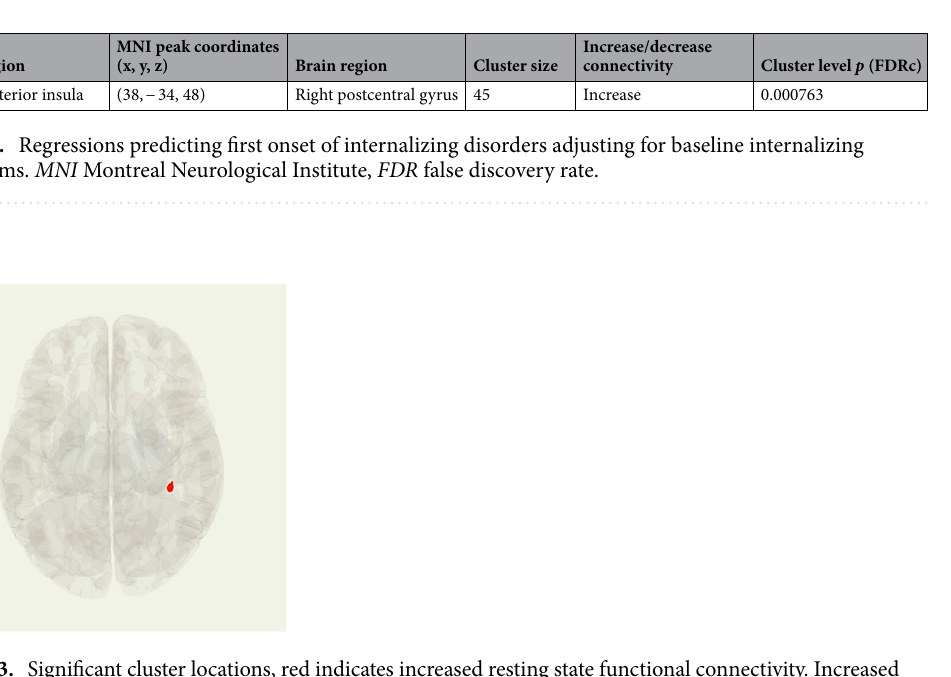
Figure 2. Significant cluster locations, red indicates increased resting state functional connectivity and blue indicates decreased resting state functional connectivity. ( a ) Increased resting state functional connectivity from the left lateral prefrontal cortex to the right fusiform gyrus. ( b ) Increased resting state functional connectivity from the right lateral prefrontal cortex to the left lingual gyrus, left fusiform gyrus, left intracalcarine cortex, and left supracalcarine cortex. ( c ) Decreased resting state functional connectivity from the left anterior insula to the right precentral gyrus.